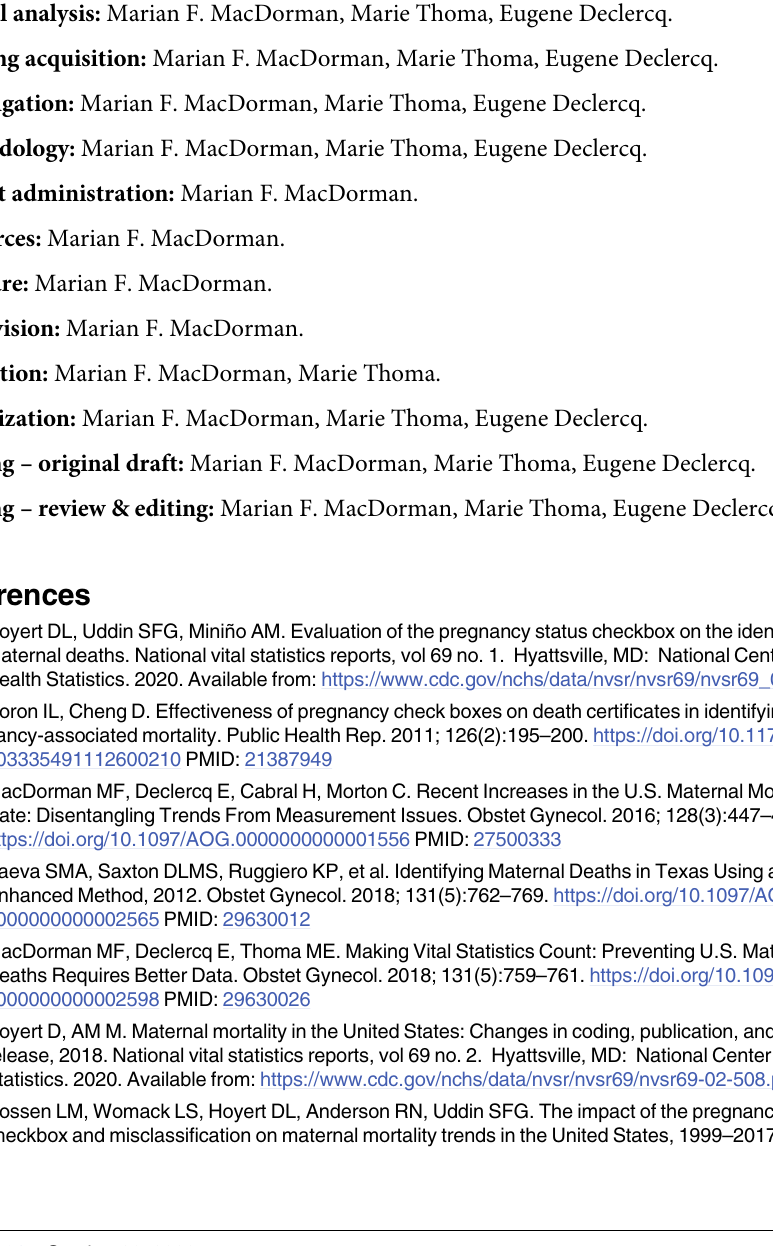
S1 Table. Pregnancy-related terms reported on death certificates, United States,